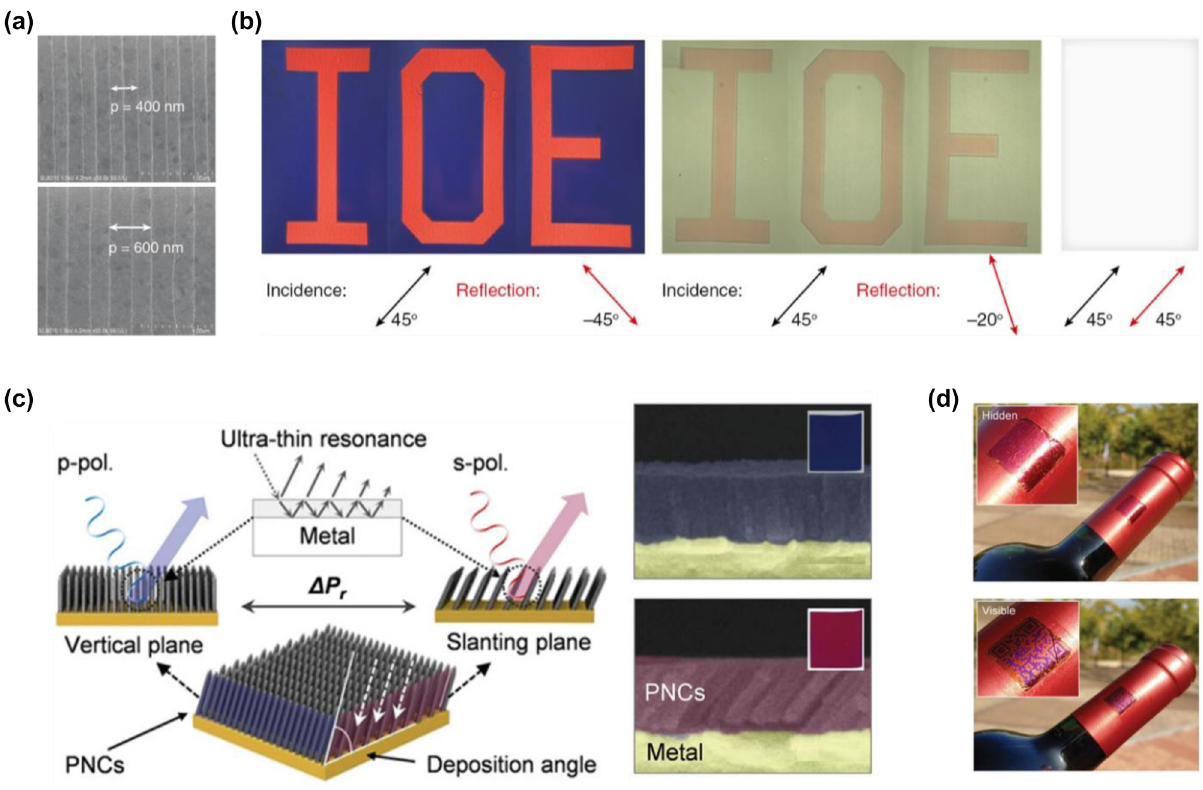
Figure 37: Dual-color encryption based on polarization-sensitive structural coloration. (a) SEM images of the plasmonic shallow grating structures. (b) Optical micrographs of the sample showing letters “IOE”, where the polarization direction of the linearly incident light is set to 45 ◦ and that of the reflection light to − 45 ◦ , − 20 ◦ , and 45 ◦ , respectively. Modified with permission [133]. Copyright 2018, Walter de Gruyter GmbH. (c) Schematic of the slated lossy nanocolumns viewed from different in-plane orientations. When viewed from the vertical plane, the nanocolumn array shows a bluish color; while viewed from the slanting plane, the array shows a purplish color. (d) Photos of the QR code metasurface placed over a curved bottleneck surface contrasting with and without encryption in an outdoor environment. Modified with permission [343]. Copyright 2020,